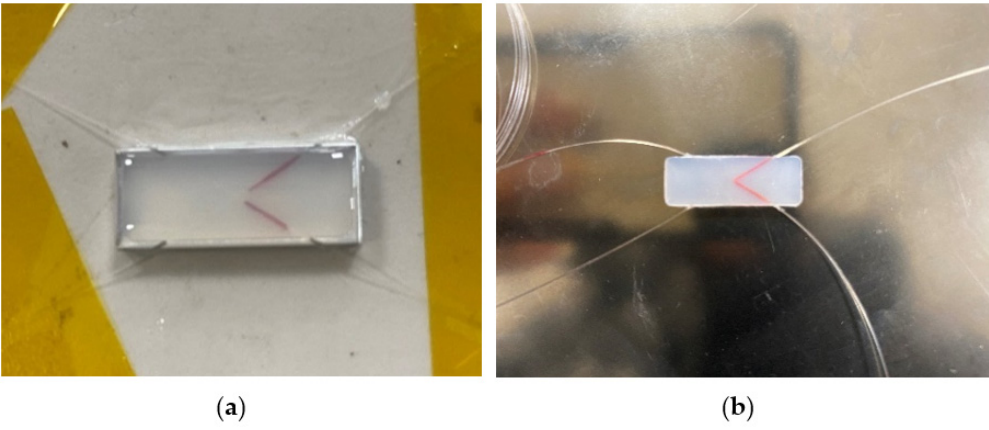
Figure 11. Fabrication of Dual FBG High-Precision Shape sensor, ( a ) Sensor curing process, ( b ) Sensor sample.